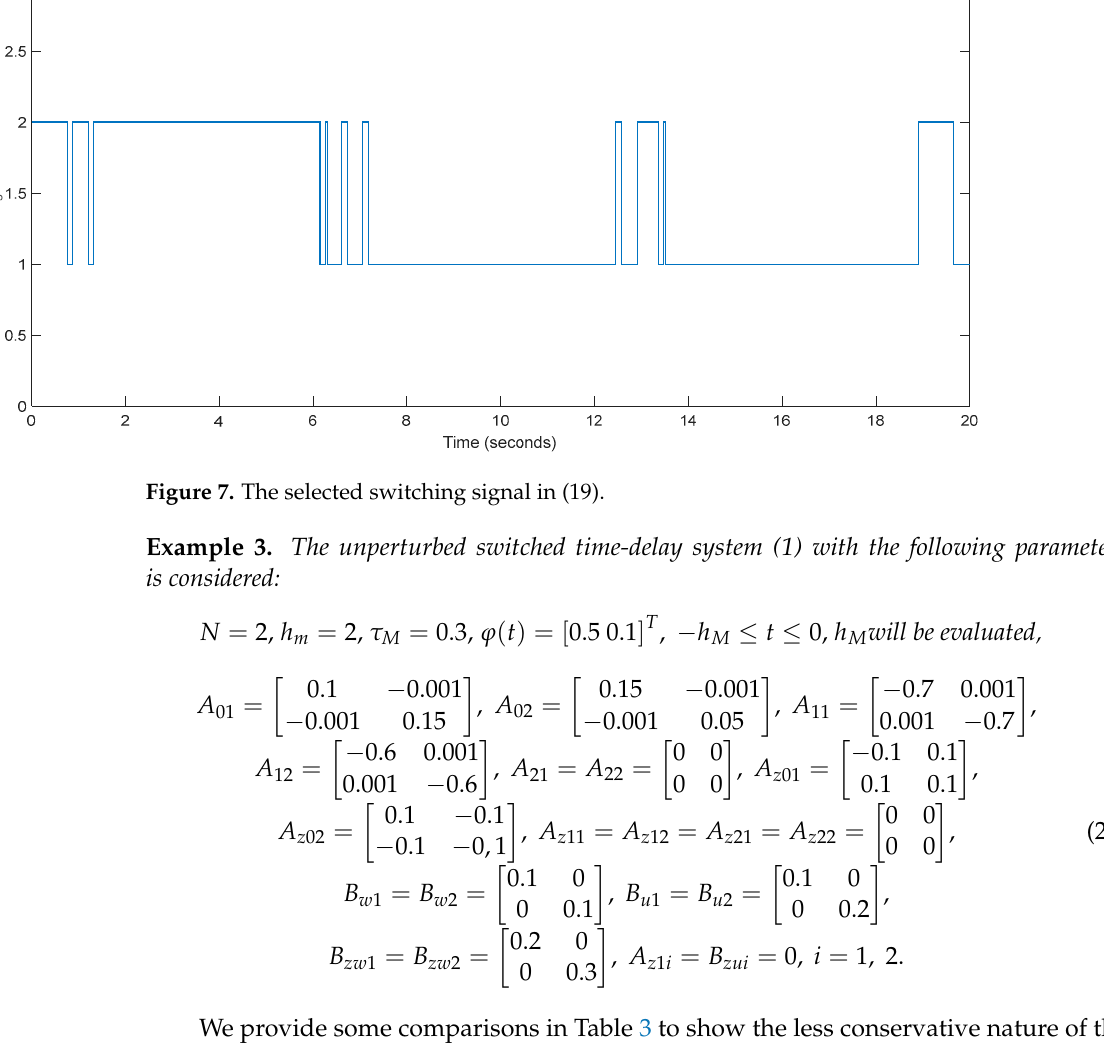
Table 3. Comparing previous results with this paper.